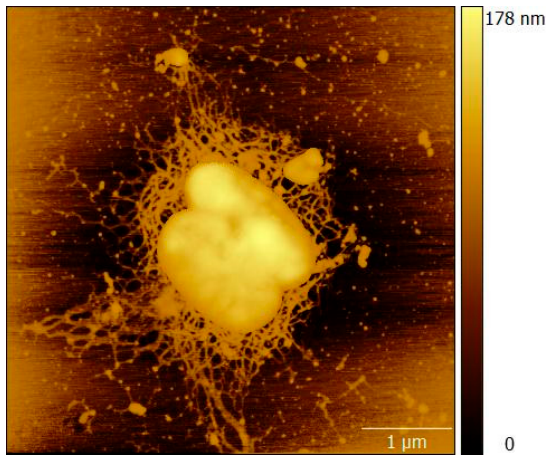
Figure 2. AFM image of R. solanacearum.